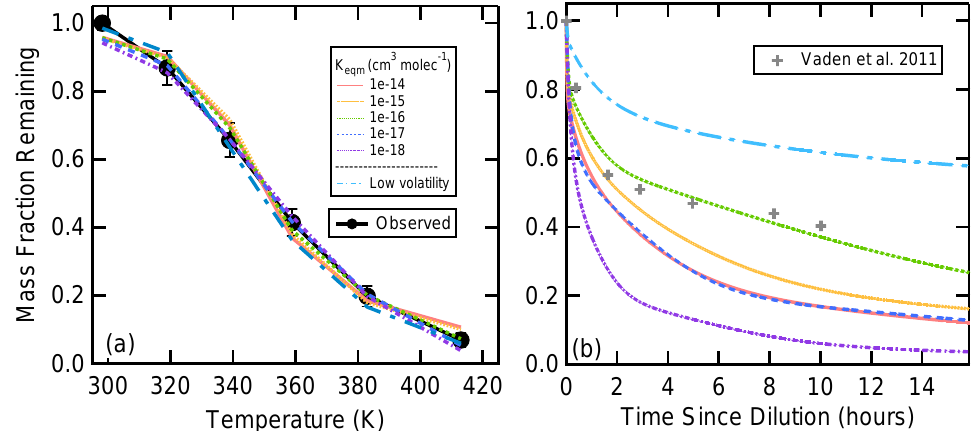
Figure 4. (a) Comparison between observed medium/low- C OA grouping (black • ) and best-fit calculated mass thermograms for the TD model that includes dimer decomposition and for the low-volatility compound model. For the dimer-decomposition model, the concentration of dimers is much greater than the concentration of monomers. (b) Simulated isothermal, room-temperature evaporation based on the best-fit model parameters determined in (a) . The initial SOA concentration was 100µgm − 3 , which was diluted by a factor of 30, and evaporated vapors were lost to the simulated chamber walls with a rate coefficient of 10 − 3 s − 1 . The grey crosses ( + ) in panel (b) are the experimental data from the isothermal dilution of α -pinene + O 3 SOA ( d p = 160nm) from Vaden et al.